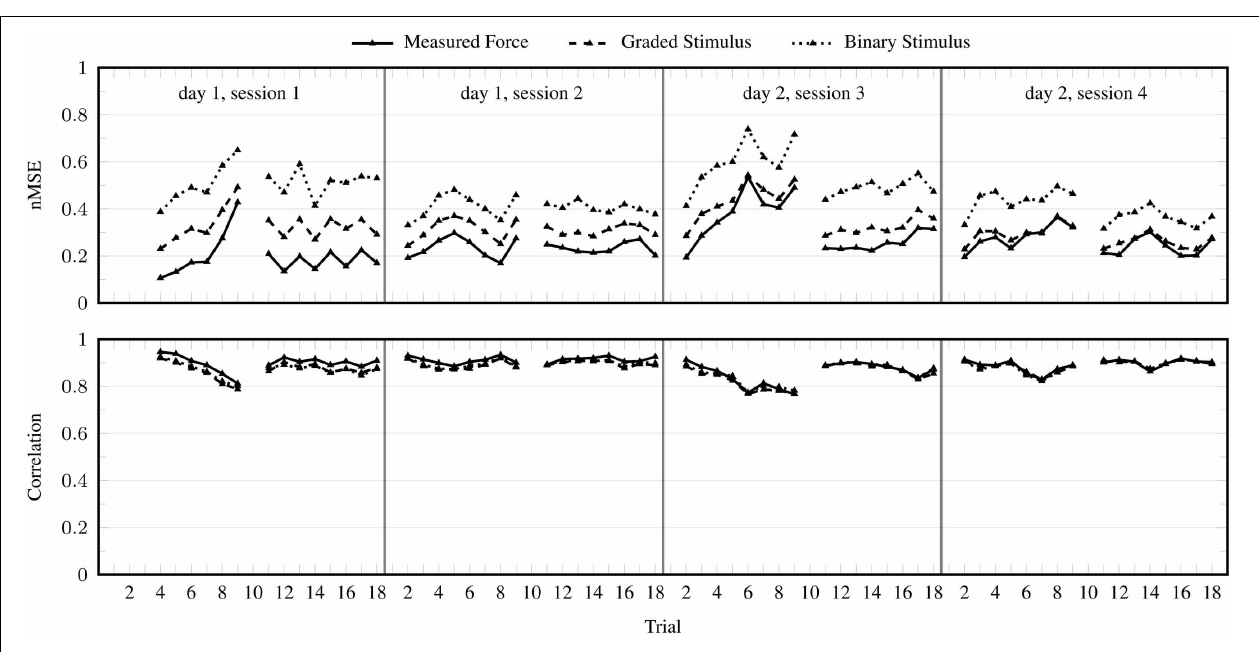
considerably better than the baseline. This result is roughly simi- lar to the performance reported by Sierra González and Castellini (2013) when predicting finger forces from ultrasound in a similar realistic setting. For comparison with their results, our nMSE ≈